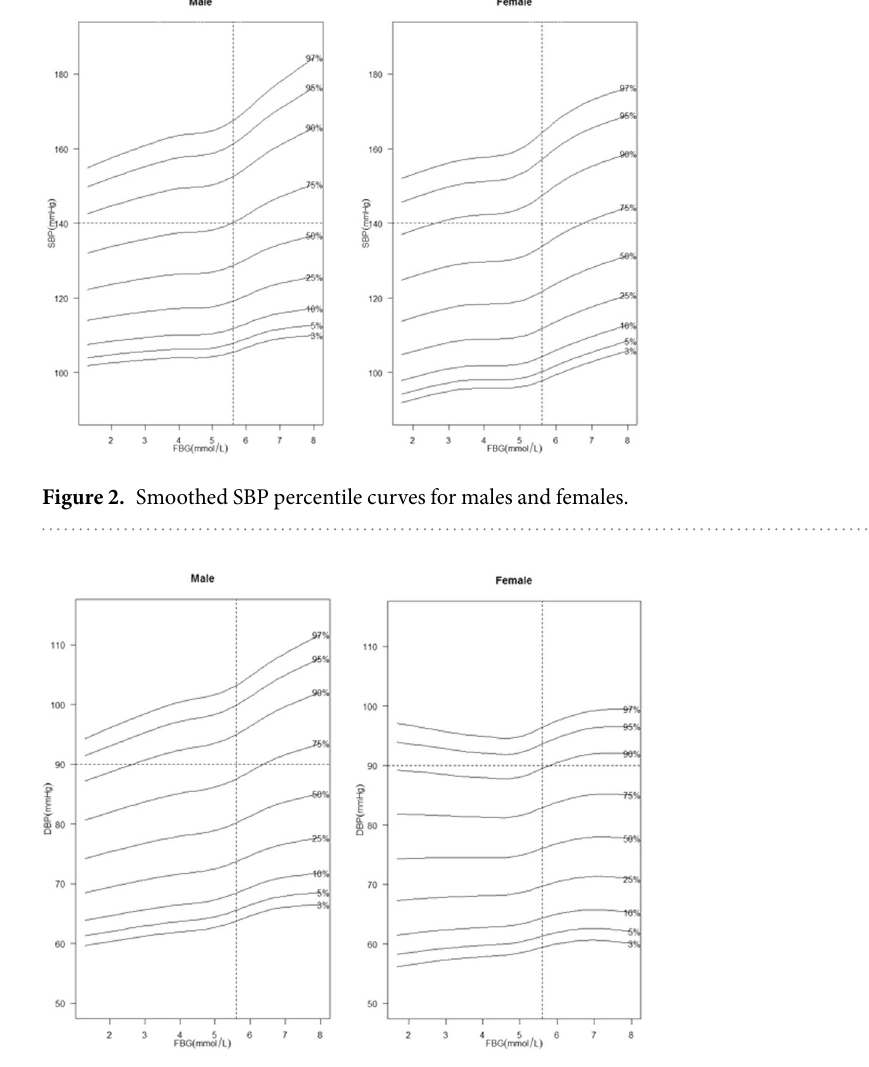
Figure 3. Smoothed DBP percentile curves for males and